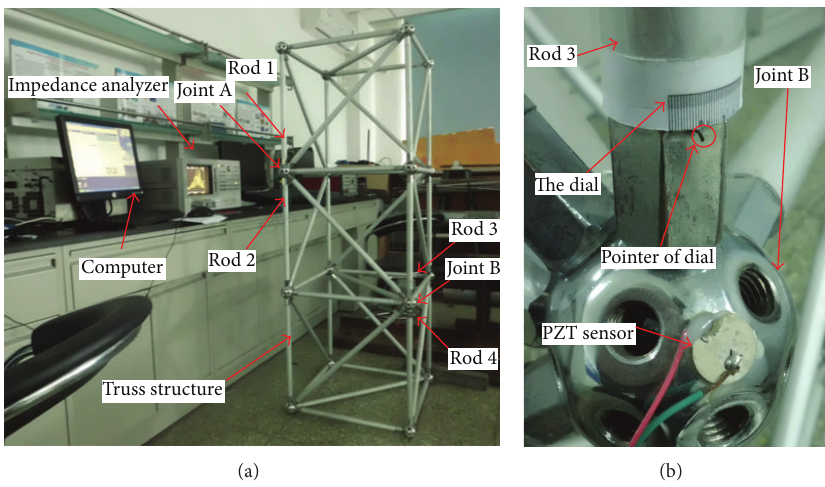
Figure 2: Experimental device and the arrangement of dial and